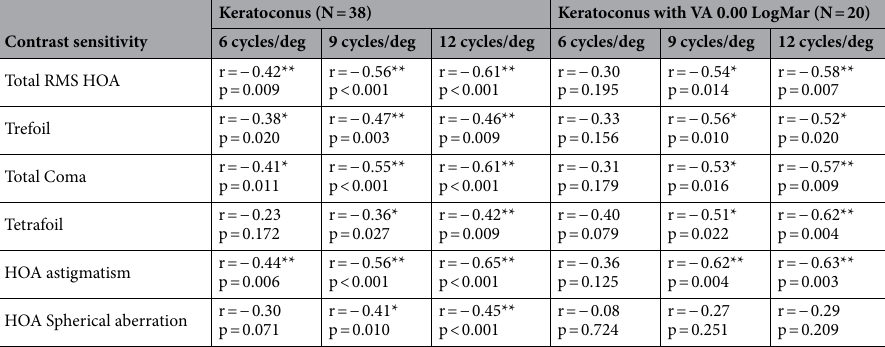
Table 3. Correlation between ocular higher-order aberrations and contrast sensitivity in 6, 9 and 12 cycles/ deg for keratoconus group and keratoconus group with visual acuity of 0.00 LogMar. *Significant level of < 0.05, **significant level of < 0.005. RMS, root mean square; HOA, higher-order aberrations; deg, degree; R, Spearman correlation